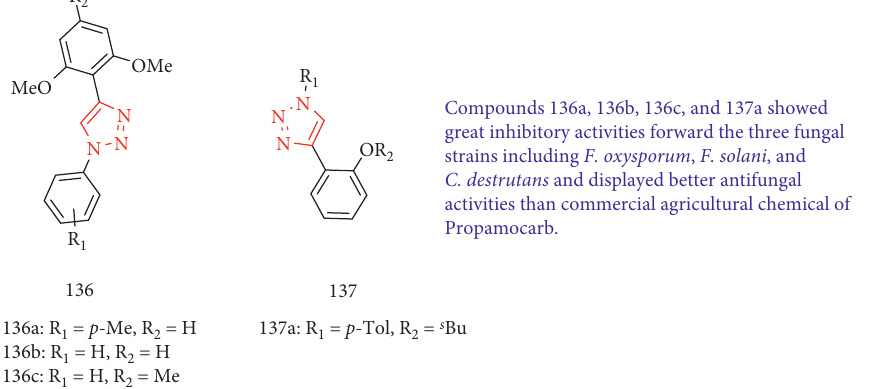
Figure 70: Chemical structure of 1, 4-disubstituted 1,2,3-triazole.